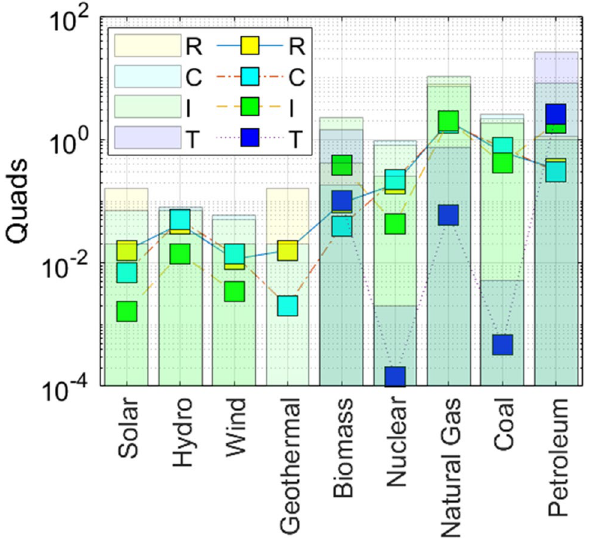
Figure 2. Quad input for each sector. Bar plot for raw energy flow (Eqs. 22–23) and square for efficiency adjusted data (Eqs.